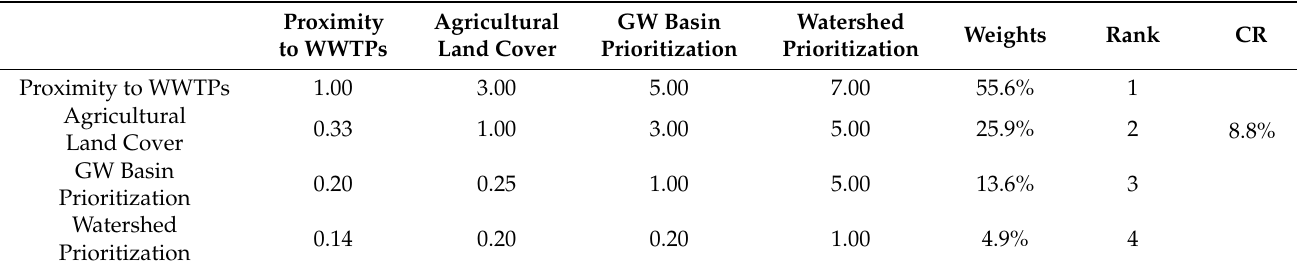
Table 4. Pairwise matrix for the decision criteria for Case 1: considering selected discharging methods. Consistency Ration (CR) was calculated based on the Equation (1).